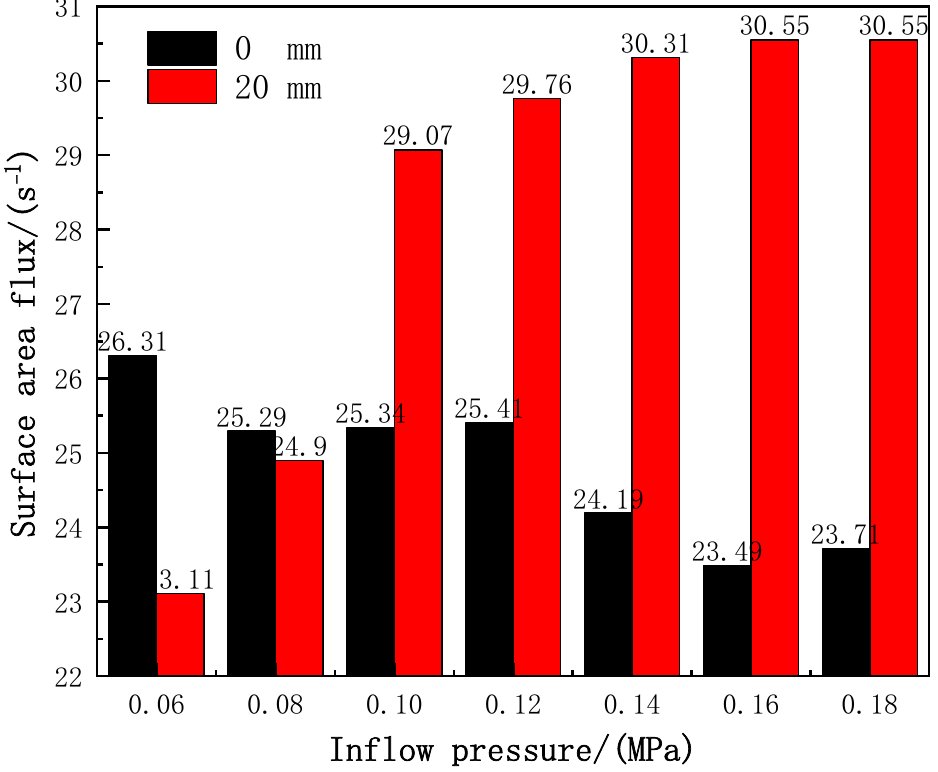
Figure 10. Influence of nozzle distance on bubble surface area